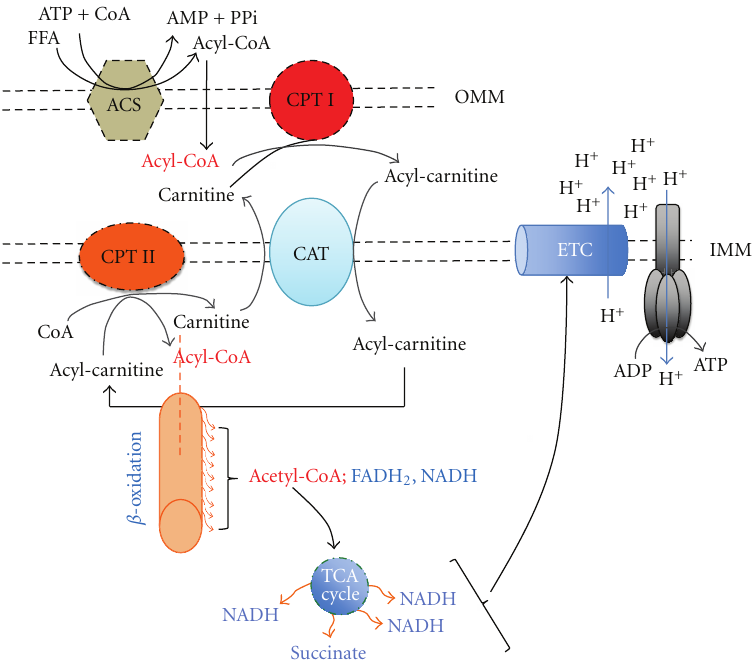
Figure 2: Transport of fatty acids from the cytoplasm to the mitochondrial matrix for oxidation. Following activation to acyl-CoA, CoA is exchanged for carnitine by carnitine palmityl transferase (CPT-I), which is then transported to the inside of the mitochondria where a reversal exchange takes place through the action of carnitine acylcarnitine translocase (CPT-II), and beta-oxidation machinery initiates its activity, producing reducing equivalents that feed the electron transport chain. More details are available in the text. CAT: Carnitine Acylcarnitine Translocase, FFA: free fatty acid, ACS: Acyl-coA synthase, ETC: electron transport chain, IMM: inner mitochondrial membrane, OMM: outer mitochondrial membrane, coA: coenzyme A, ATP: adenosine triphosphate, ADP: adenosine diphosphate, and AMP: adenosine